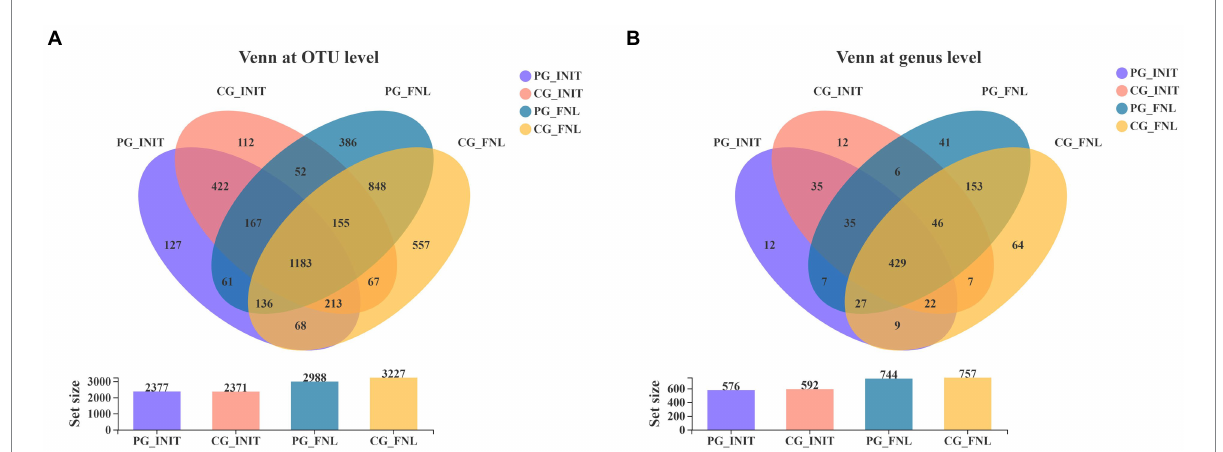
FIGURE 4 Venn diagrams of PG and CG groups at the initial and final stages of the experiment, including the Venn diagrams at the OTU level (A) and genus level (B) . PG_INIT and CG_INIT represented the PG and CG groups at the initial stage of the experimental period, respectively. PG_FNL and CG_ FNL represented the PG and CG groups at the final stage of the experimental period,